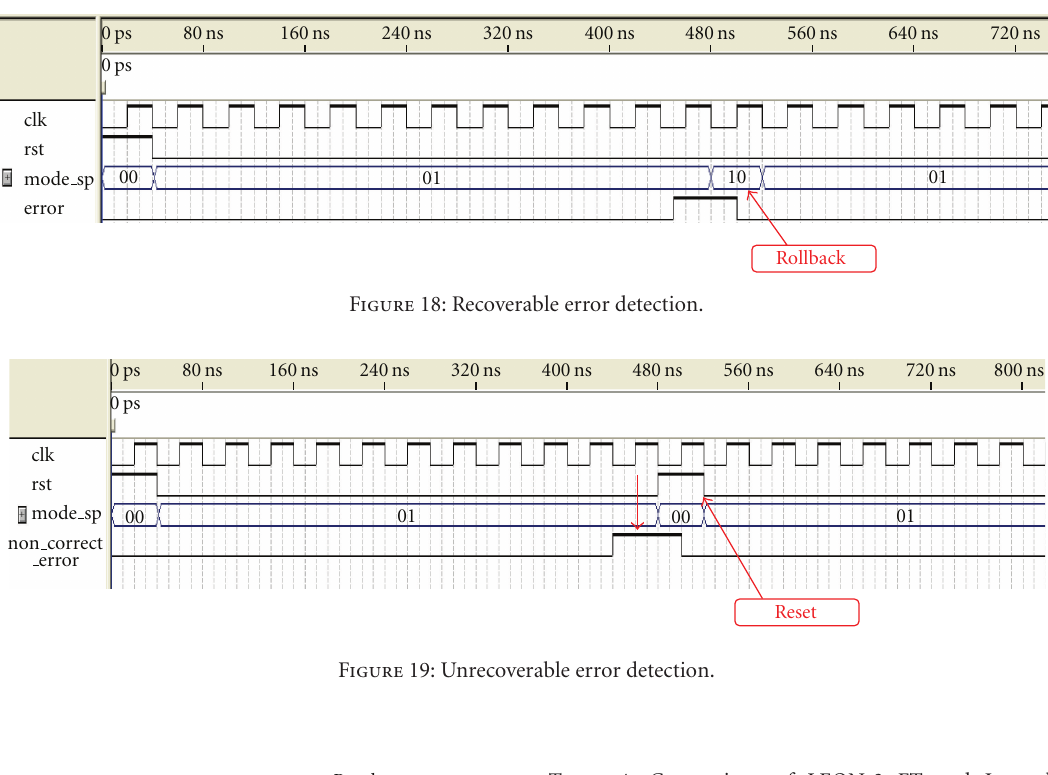
Table 4: Comparison of LEON-3 FT and Journalized